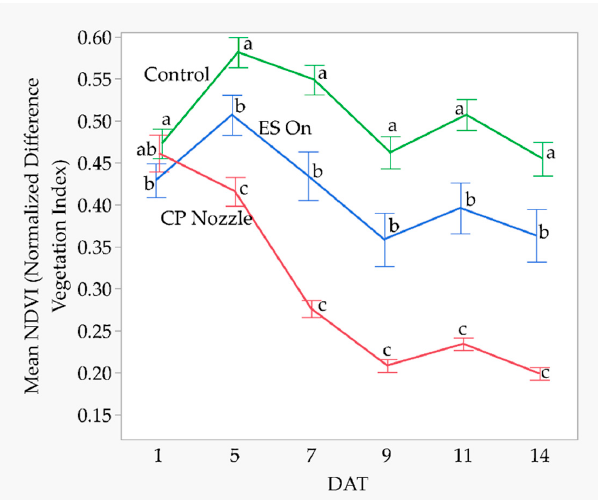
Figure 7. Mean NDVI at 1, 5, 7, 9, 11, and 14 days after treatment (DAT). Means ( ± SEM) within each DAT followed by the same lowercase letter are not significantly di ff erent ( p < 0.05) according to Tukey’s HSD test. The treatments shown in the graph are the Control, the Electrostatic charged on (ES On), and the conventional CP